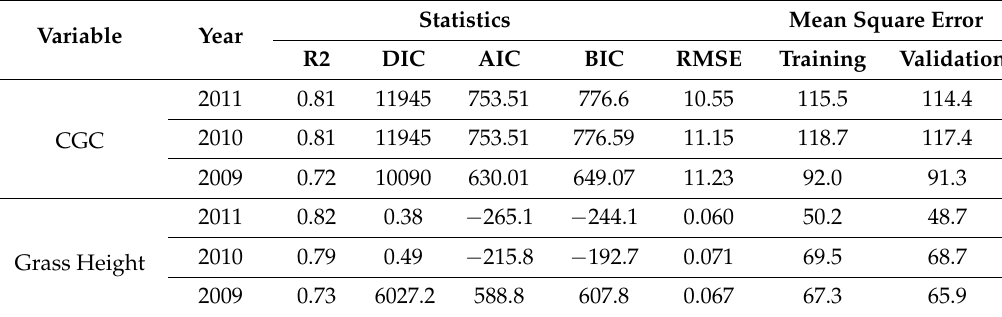
Table 2. Coefficients of determination of linear regression models ( p < 0.01).